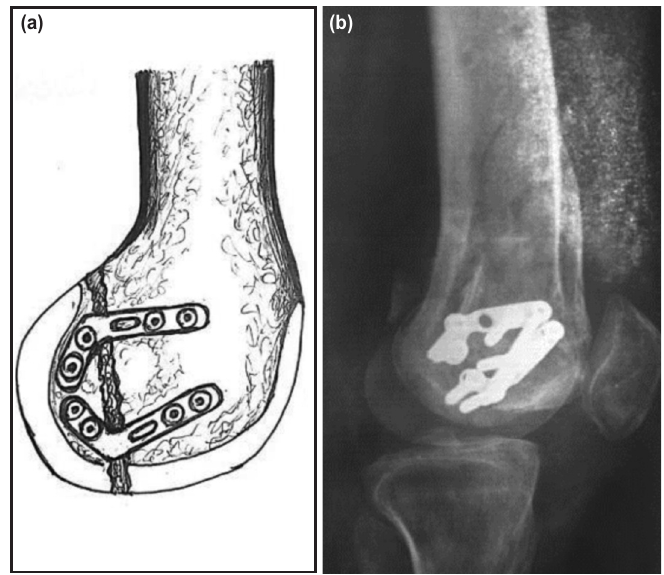
Depicting non-union of lateral Hoffa after Fig. 1: one year of index surgery.